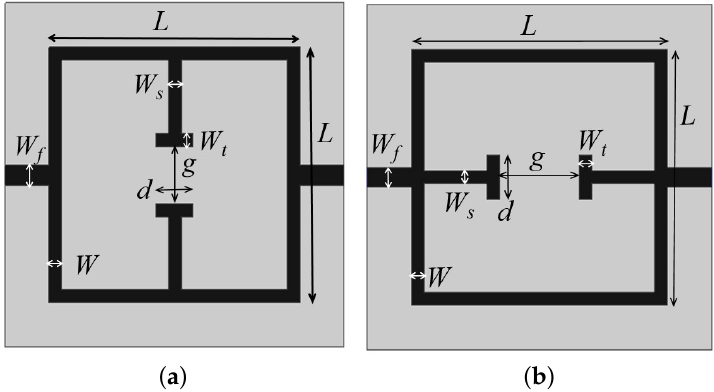
Figure 5. Geometry of the other two sensors realized introducing a T-shaped on the stubs head: ( a ) perpendicular, ( b ) parallel to microstrip feeding